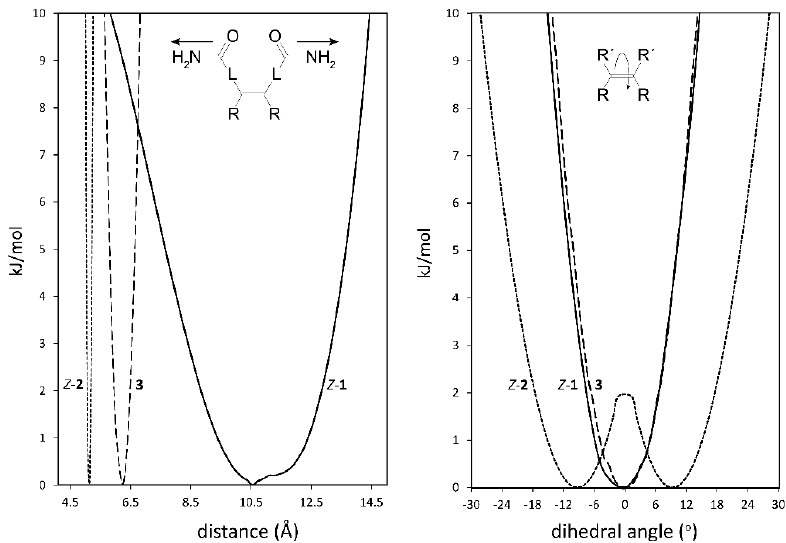
Figure 3. Energy profiles for spacer dihedral angle variation ( right ) and for spacer C=O–C=O distance variation ( left ) in bisporphyrin tweezers Z - 1 ( - ), Z - 2 ( … ) and 3 (---). L represents the spacer between